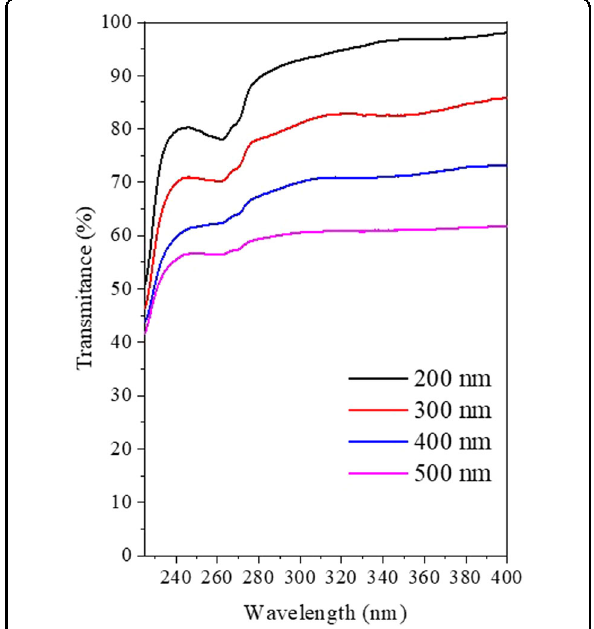
Fig. 5 Transmittance measurement of nanonetwork chitosan thin fi lms. Transmittance spectra of gyroid-structured nanoporous chitosan monoliths fabricated with thickness ranging from 200 to 500